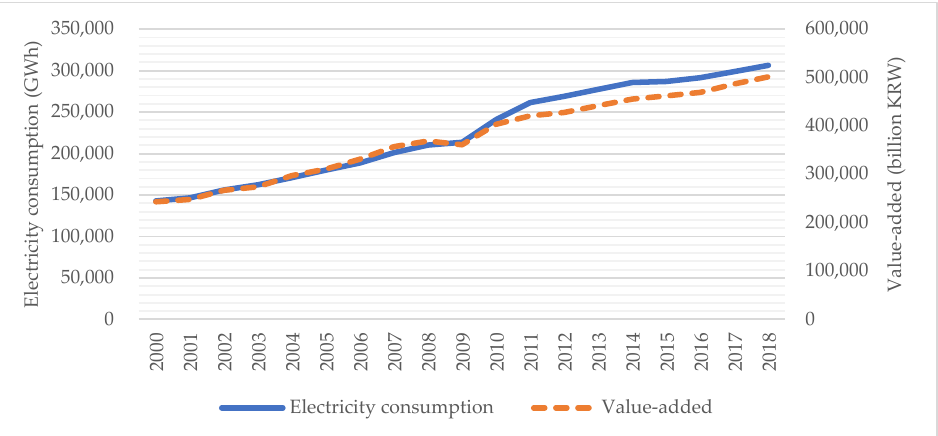
Figure 1. Electricity consumption and value added of the Korean industrial sector (2000–2018). Table 1. Electricity consumption, value added, and shares in 2000 and